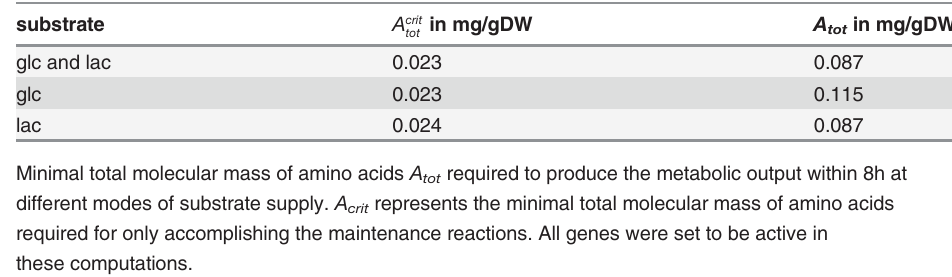
Table 2. Minimal total molecular mass of amino acids. substrate